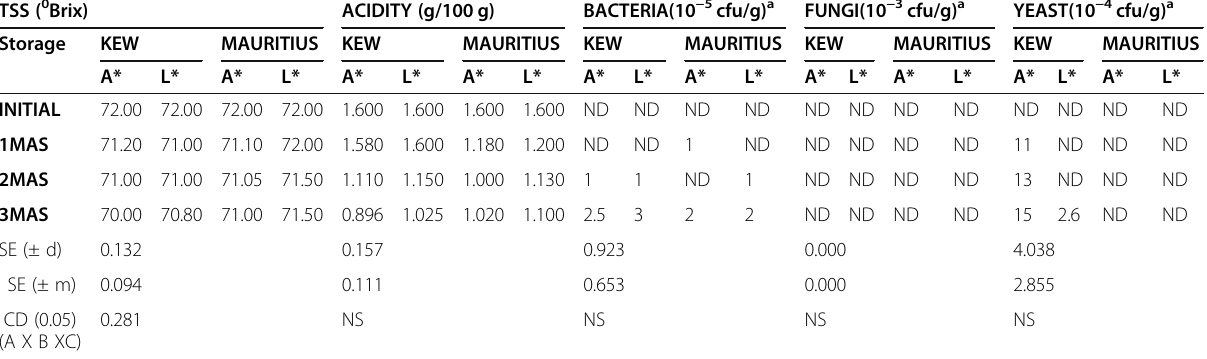
Table 2 TSS ( 0 Brix), Acidity (g/100 g) and microbial quality of intermediate moisture pineapple slices during